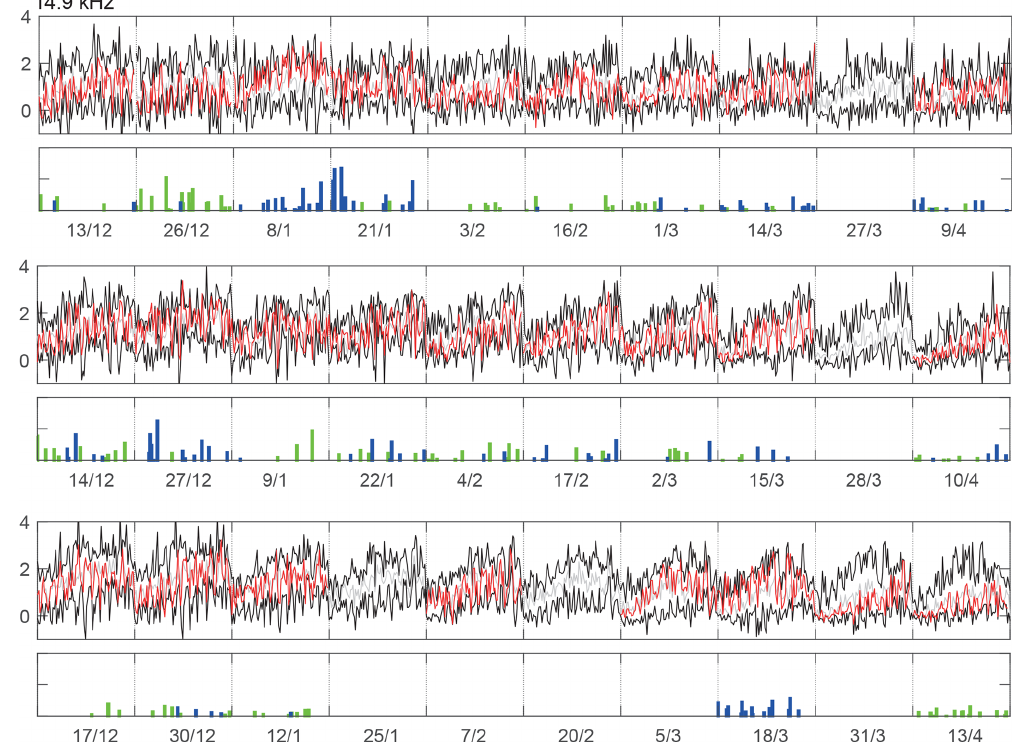
Figure 5. A revisit orbital SNR of 9, 10, and 13 April 2010. The red, gray, and two black curves denote the currently observed SNR, associated median, and upper and lower bound (UB and LB), respectively. Blue and green bars represent the positive and negative anomalies in one orbit, respectively. The LB and UB are constructed by the 6d moving median (M, including 3d before the current day and 2d after the current day), lower quartile (LQ), and upper quartile (UQ), and the LB and UB are calculated by LB = M + 2(M-LQ) and UB = M + 2(UQ-M).